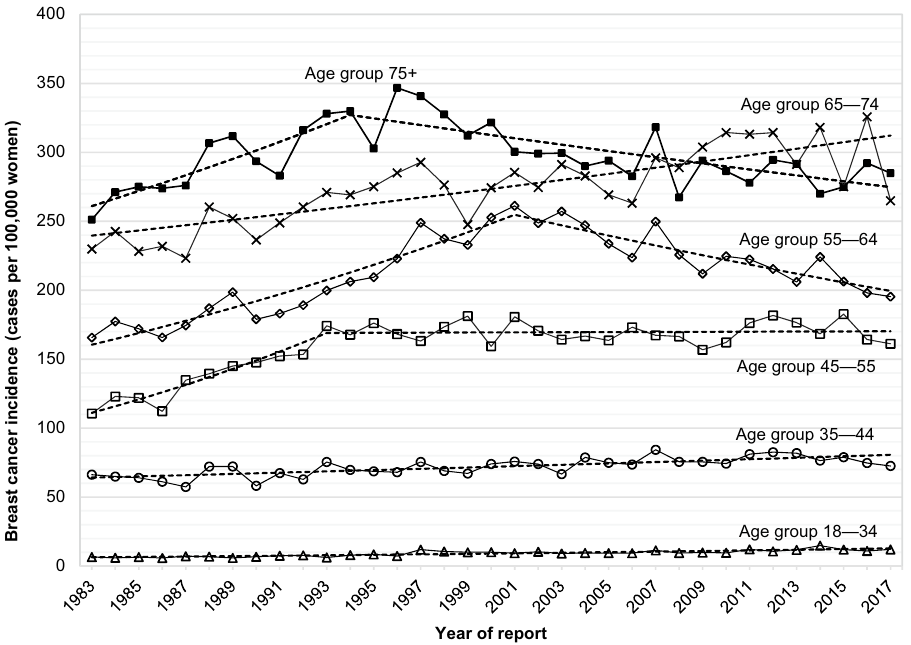
Figure 3. Age-specific incidence of breast cancer in women in Austria according to year of diagnosis, 1983– 2017 (crude rates). Dashed lines indicate joinpoint regression estimates.